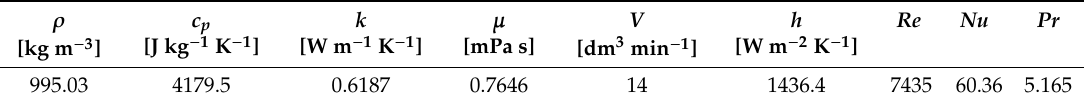
Table 1. Thermophysical properties of solids materials.